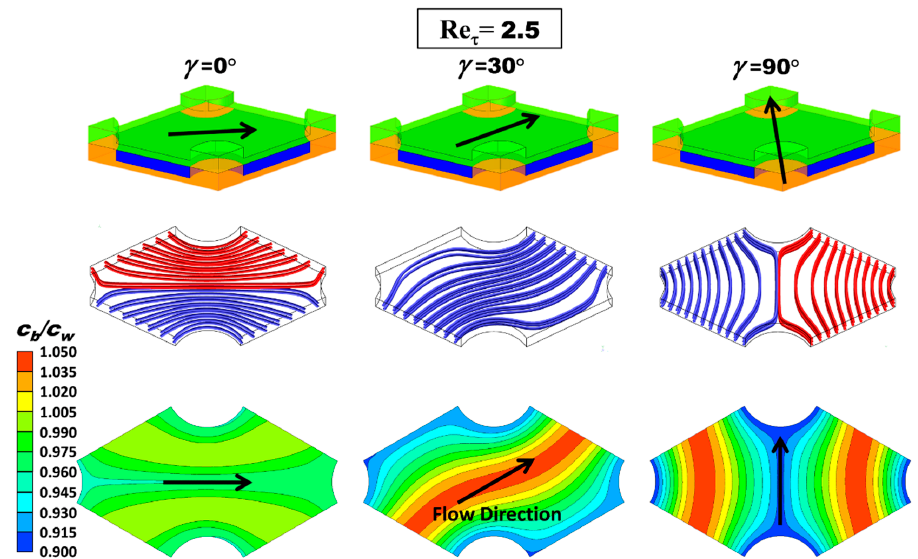
Figure 7. Illustrating the flow direction (top row), 3-D streamlines (middle row), and maps of the concentration polarization coefficient θ = c b /c w on either of the walls (bottom row) for the P/H = 10 undeformed configuration and a friction velocity Reynolds number of 2.5 (Re = 5.1). c b = 500 mol/m 3 , flux corresponding to a current density of 50 A/m 2 entering the fluid domain (dilute channel of a reverse electrodialysis (RED) or concentrate channel of an electrodialysis (ED)).